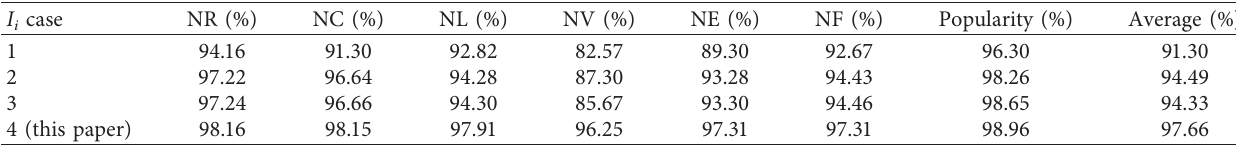
Table 20: Comparison of accuracy of experimental